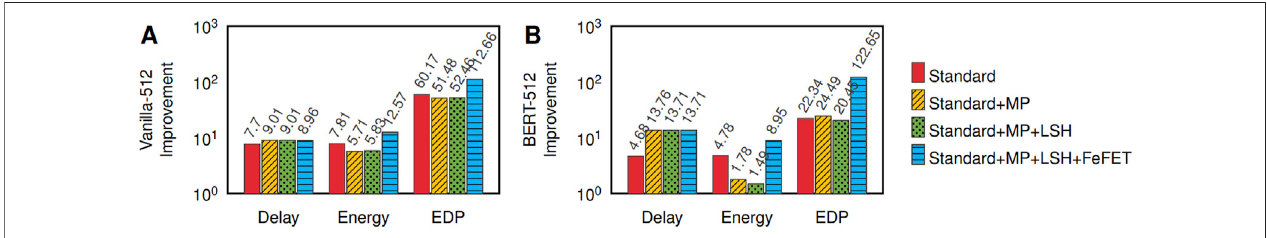
FIGURE 8 | Delay, Energy and EDP improvement for the Vanilla Transformer (A) and BERT (B) with sequence length of 512 with respect to additional enhancement: Model Parallelism (MP), Locality Sensitive Hashing (LSH) and using FeFET